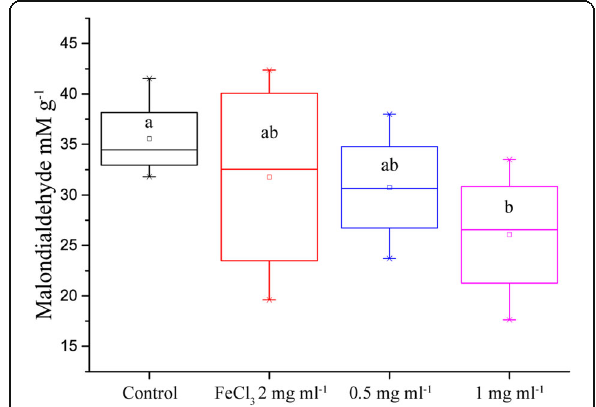
Fig. 8 Low-temperature (2 K) magnetization of ashed leaves of plants treated with maghemite nanoparticles compared to control plants. Error bars show standard error of mean ( n = 6)